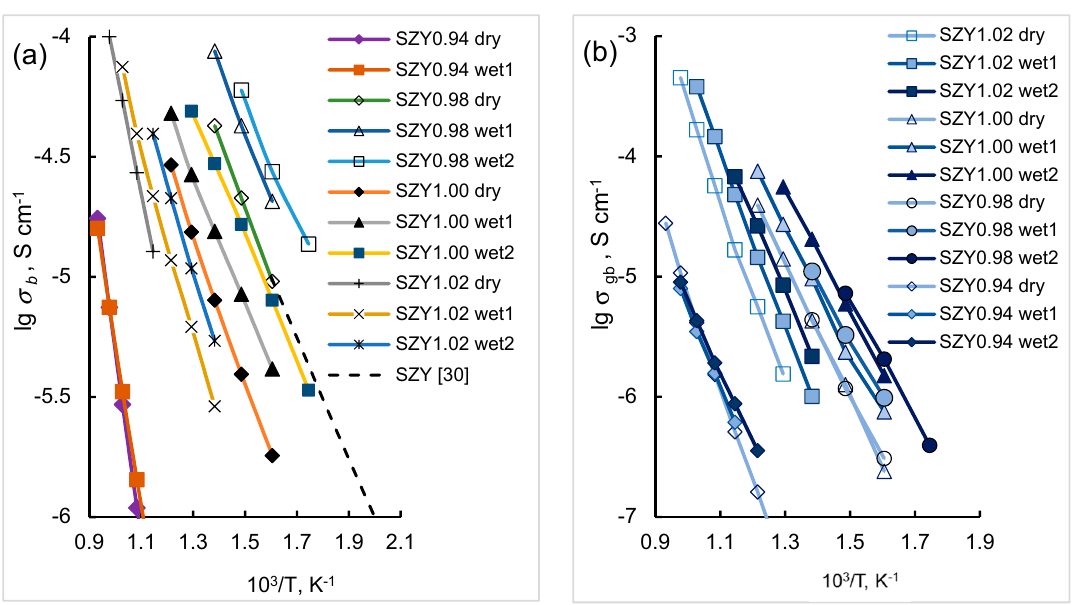
where K 6 is an equilibrium constant of the Equation (6).